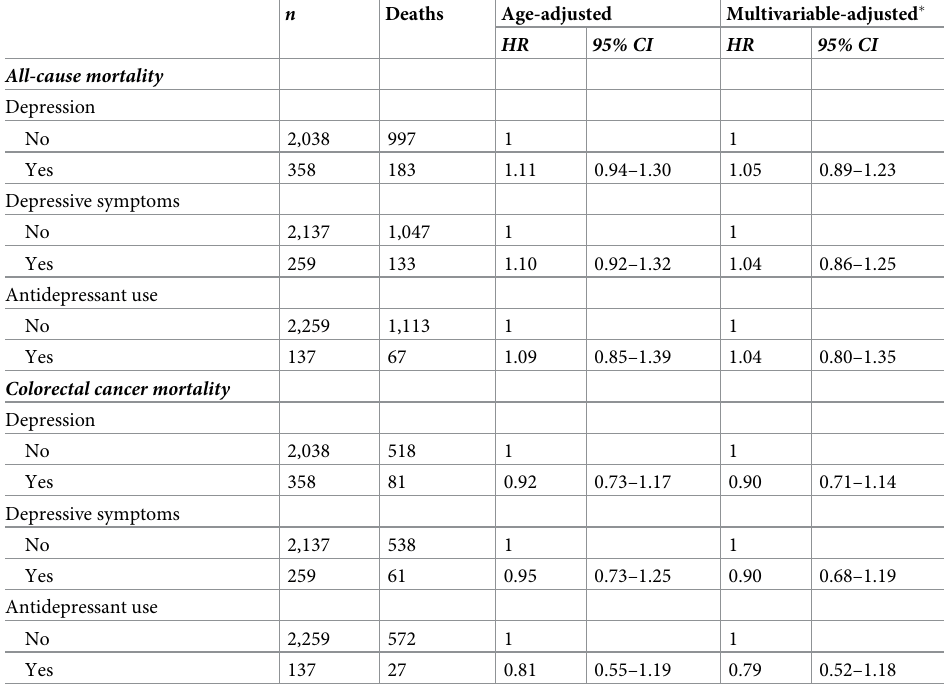
Table 2. Hazard ratios (HRs) and 95% confidence intervals (CIs) for all-cause mortality and colorectal cancer spe- cific mortality in relation to depression at WHI baseline.